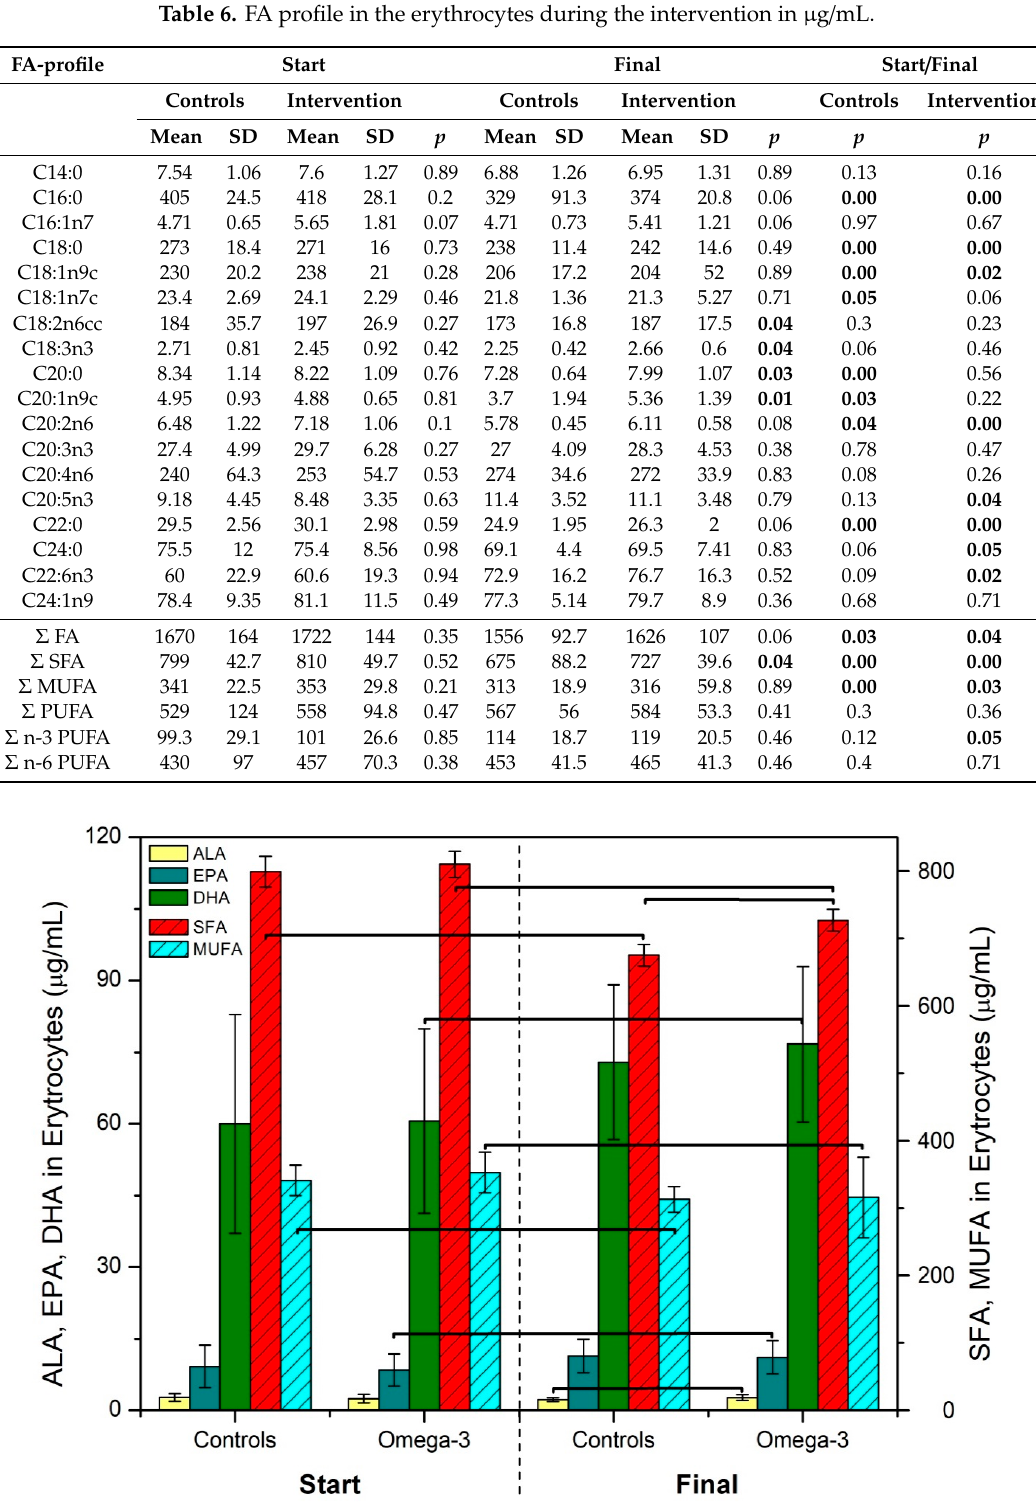
Figure 1. Comparison of the difference in the contents of ALA, EPA, DHA, Σ SFA and Σ MUFA during the intervention. Statistically significant differences between the individual groups with p < 0.05 are designated by a bracket. α -linolenic acid (ALA), eicosapentaenoic acid (EPA), docosahexaenoic (DHA), saturated fatty acids (SFA), monounsaturated fatty acids (MUFA)